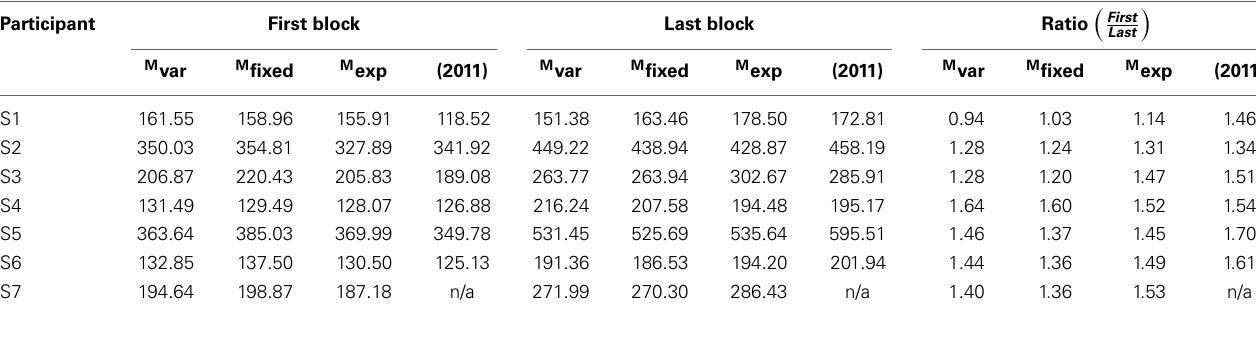
Table 4 | Estimated first and last reading speeds, calculated as estimated 80% point on PF converted to WPM using WPM = 60 × 1000 marked (2011) show results of Chung (2011) study, which used a different method of